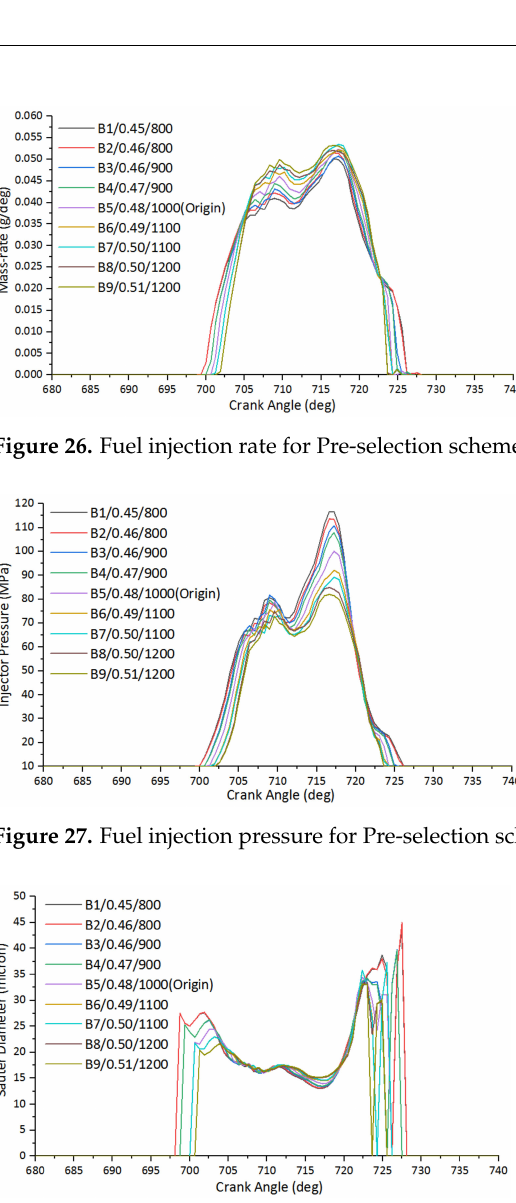
Figure 28. Fuel SMD for Pre-selection